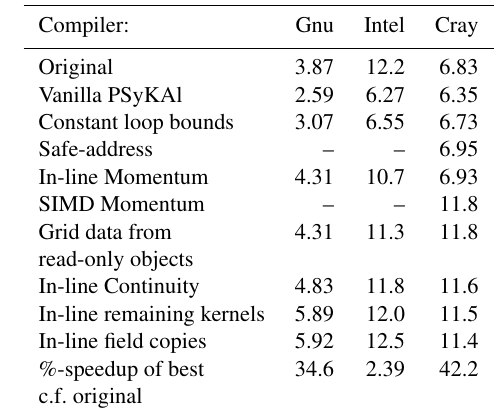
Table 4. Performance (millions of points updated per second) on an Intel Ivy Bridge CPU for the 256 2 case after each code transforma- tion. Where an optimization uses compiler-specific directives then performance figures for the other compilers are